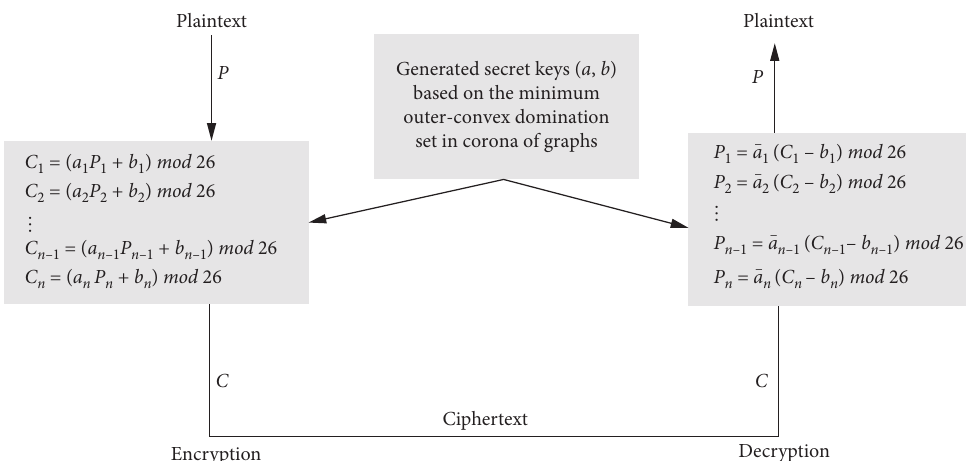
Figure 1: Proposed polyalphabetic affine cipher based on the minimum outer-convex dominating set in the corona of